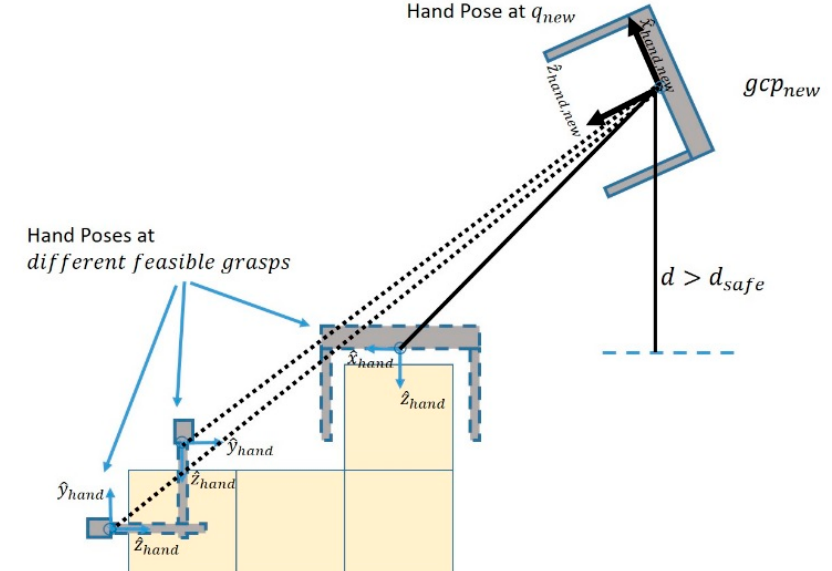
Figure 6. The idea of node association to one of the feasible grasp for a part is presented. When a q new be a new node added to the tree in C − space , d be the distance of gcp new from feasible grasp of the part. If the component of the d along the − ˆ z hand of the feasible grasp is greater than d safe (minimum safe distance of hand from part to change orientation of hand), then the new node will be associated to the feasible grasp which has normal more closely aligned to the line joining the grasp center point and center of the